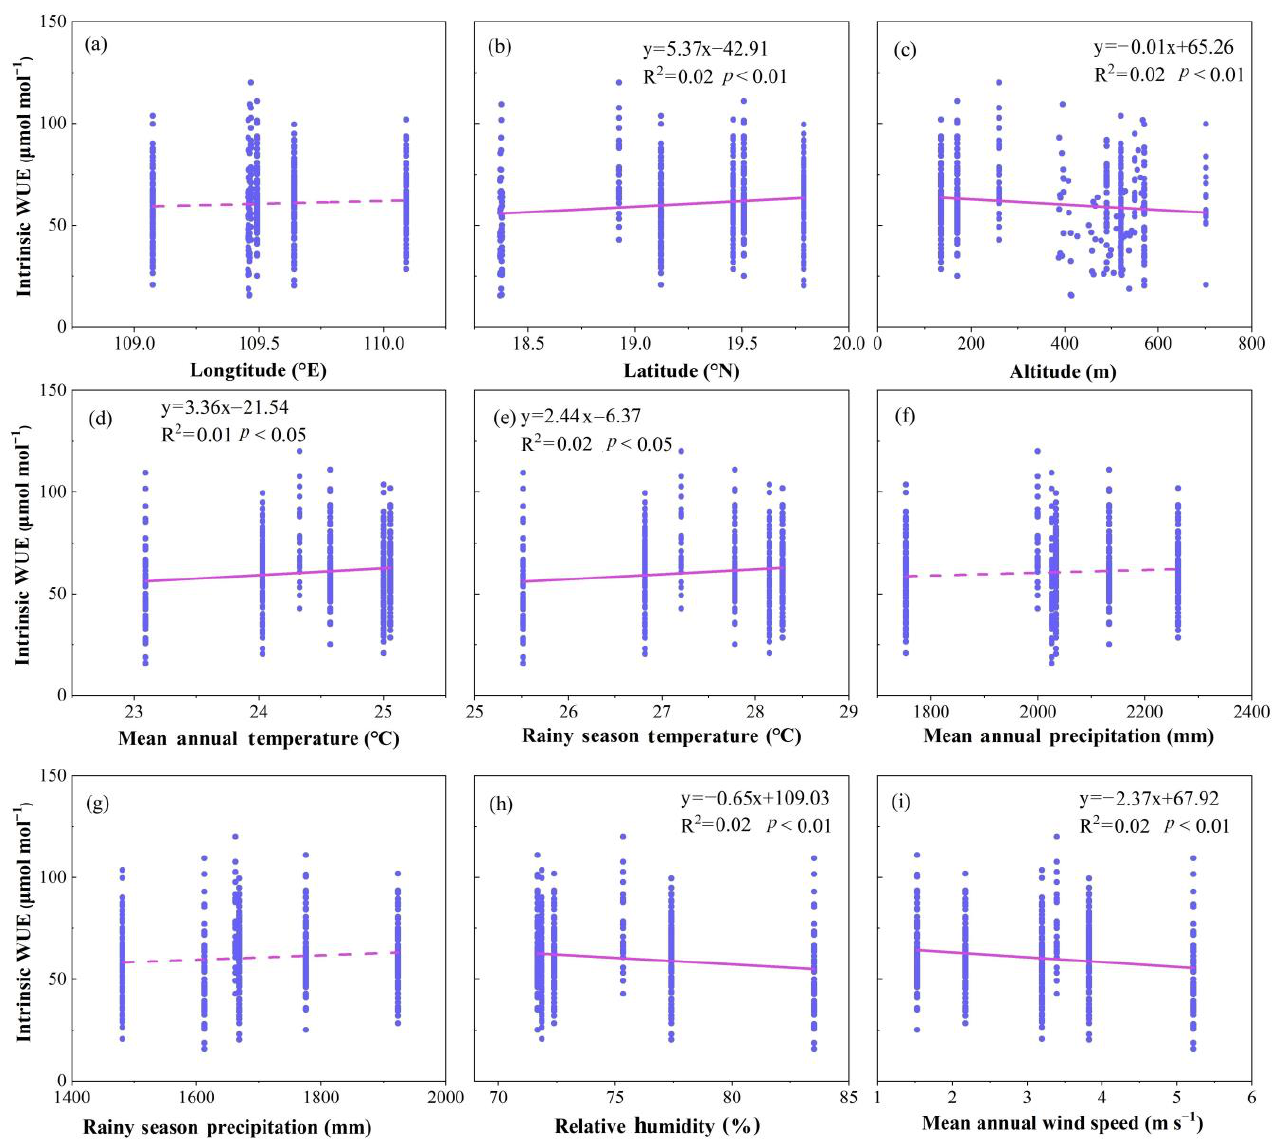
Figure 3. Changes in intrinsic water use efficiency (intrinsic WUE) with geographical climatic factors in all samples. ( a ) Intrinsic WUE vs. longitude; ( b ) intrinsic WUE vs. latitude; ( c ) intrinsic WUE vs. altitude; ( d ) intrinsic WUE vs. mean annual temperature; ( e ) intrinsic WUE vs. rainy season temperature; ( f ) intrinsic WUE vs. mean annual precipitation; ( g ) intrinsic WUE vs. rainy season precipitation; ( h ) intrinsic WUE vs. relative humidity; ( i ) intrinsic WUE vs. mean annual wind speed. The scatter points in the figure represent the measured intrinsic WUE of plant leaves. The dotted line indicates that the correlation between intrinsic WUE and climatic factors is not significant ( p > 0.05). The solid line indicates that the correlation between leaf intrinsic WUE and climatic factors is significant ( p <